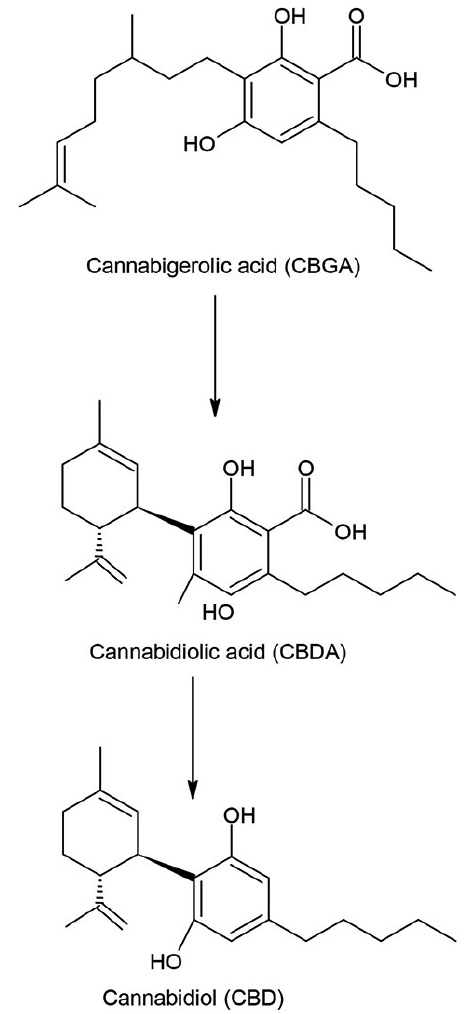
Figure 4. Hemp plants convert cannabigerolic acid (CBGA) into cannabidiolic acid (CBDA), which is then transformed in the laboratory to cannabidiol (CBD) and carbon dioxide (CO 2 ) [3]. CBD is obtained from the top part of hemp, e.g., from plant panicles. Main processing